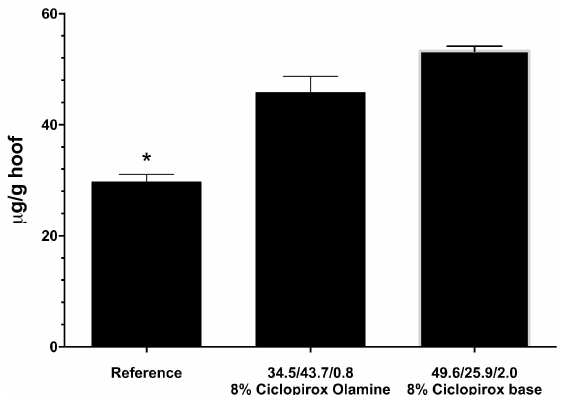
Figure 6. Trans-hoof di ff usion kinetics of ciclopirox olamine and ciclopirox base, compared with the same for the commercial reference lacquer used.